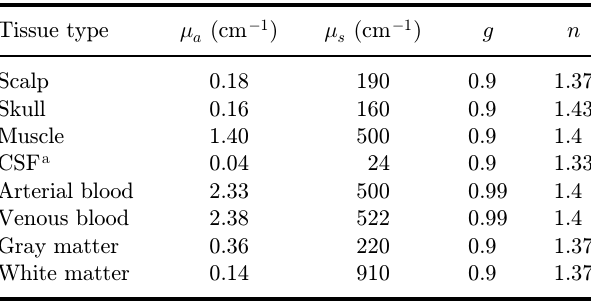
Table 1. Optical properties of head tissues for 800-nm light. Tissue type